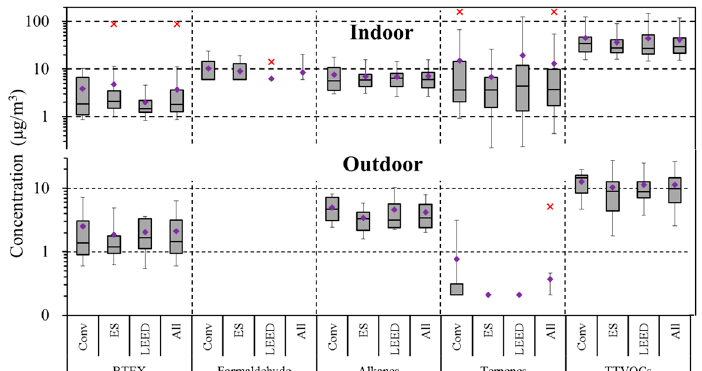
Figure 5. Box plots of indoor and outdoor concentrations of BTEX, formaldehyde, alkanes, terpenes and TTVOCs grouped by three building types: conventional (Conv), EnergyStar (ES), and LEED. Plots show 5th, 25th, 50th, 75th and 95th percentile concentrations. Diamond ( ♦ ) shows mean; Crosses (x) show outliers.